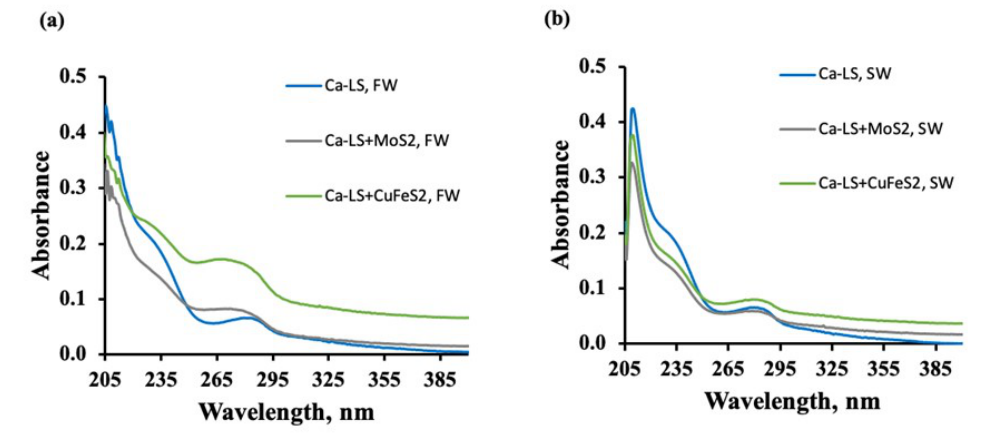
Figure 10. Absorbance spectra of Ca-LS (10 ppm) before and after contact with molybdenite and chalcopyrite in ( a ) freshwater (0.01 M NaCl) and ( b ) seawater.